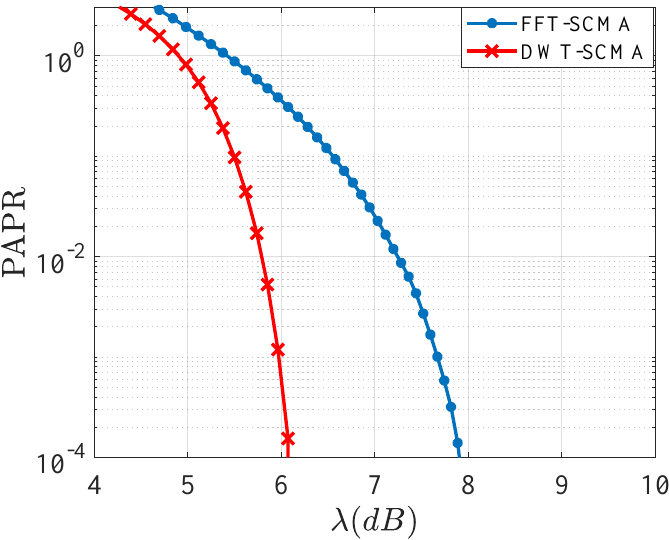
Figure 10. Comparison of PAPR performance of FFT-SCMA with